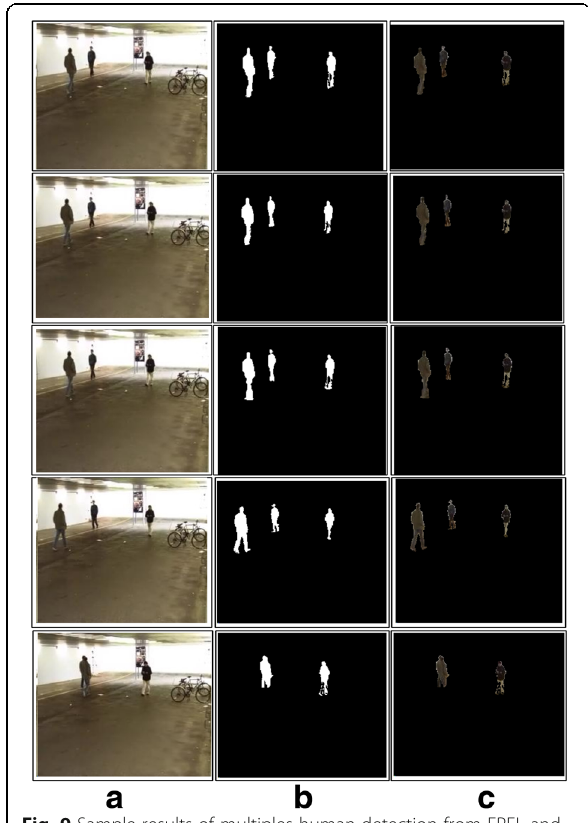
Fig. 9 Sample results of multiples human detection from EPFL and own recorded